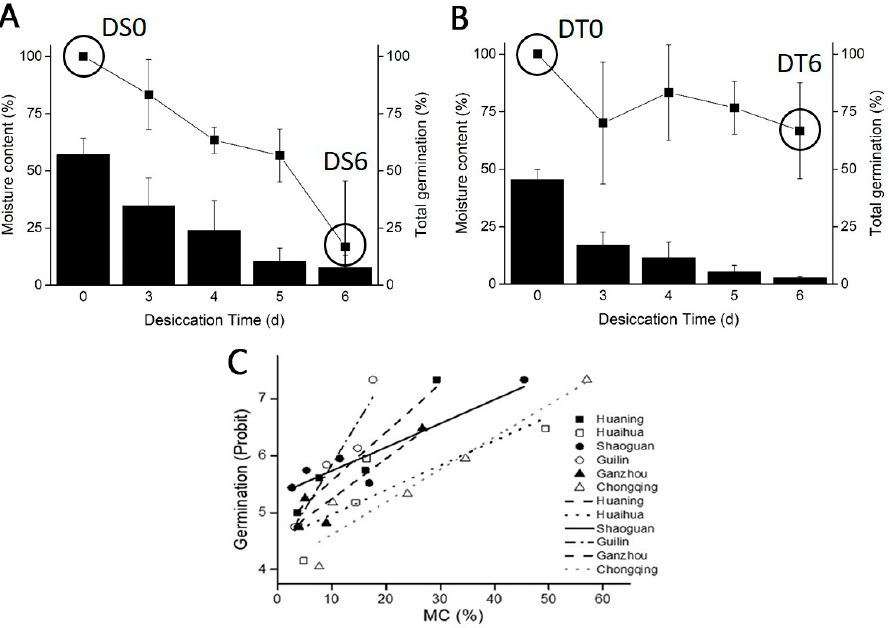
Figure 1. Effect of drying on seed parameters of Citrus sinensis ‘bingtangcheng’ seed lots. Total germination (TG, filled squares) response of ( A ) Chongqing (desiccation sensitive, DS) and ( B ) Shaoguan (desiccation tolerant, DT) seed lots ( n = 3 biological replicates of 10 seeds each) after drying for up to 6 days (DS6, DT6) to different moisture contents (filled bars). Whole seed moisture contents (MC) were determined for three biological replicates of 10 seeds each. Data represent means ± SD. ( C ) Plot of the relationship between MC and TG (probit scale) for Huaning ( ■ ), Huaihua ( □ ), Shaoguan ( ● ), Guilin ( ○ ), Ganzhou ( ▲ ), Chongqing ( △ ). Data represent mean TG at each MC. Table 1. Details of the six seed lots of Citrus sinensis ‘bingtangcheng’ studied. MC (%) at TG probit 5.5 is a measure of seed DT (the lower this MC, the higher the DT).